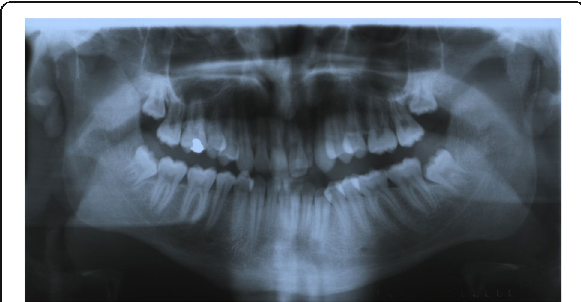
Fig. 12 Post-surgical orthopantomograph demonstrating surgically